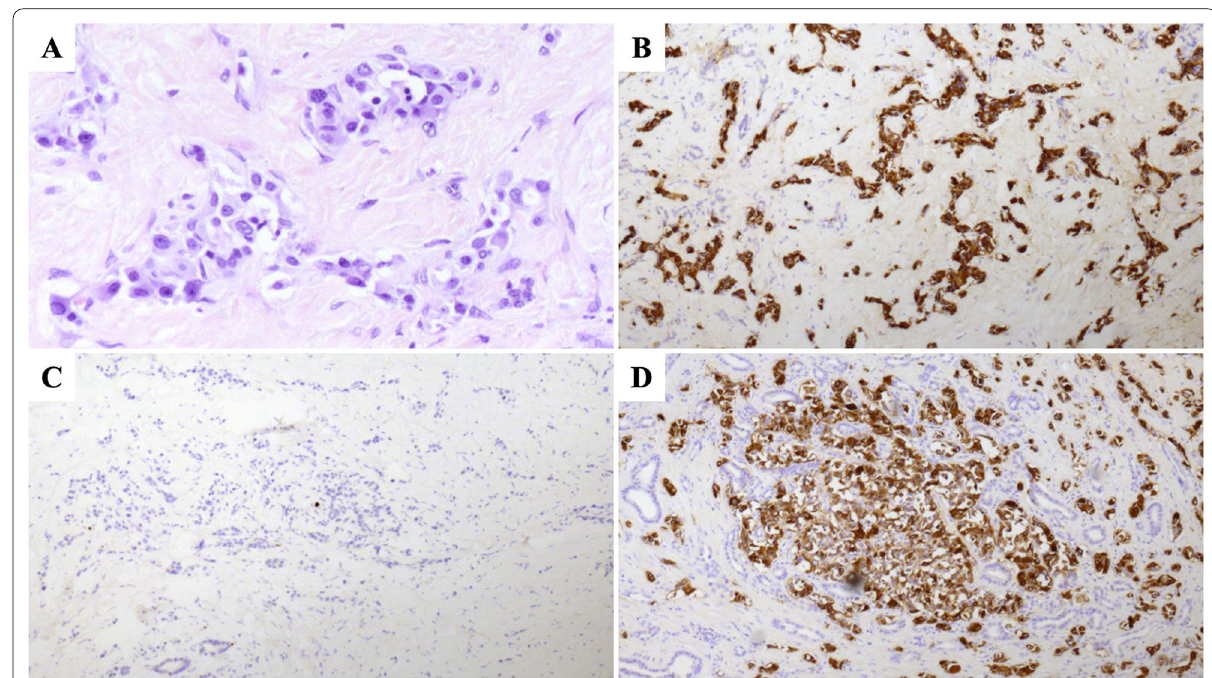
Fig. 6 Histologic examination shows a neuroendocrine tumor G1 in the pancreas similar to the liver tumors. A Hematoxylin–eosin staining. B Positive for chromogranin-A. C Ki-67 < 1%. D Positive for